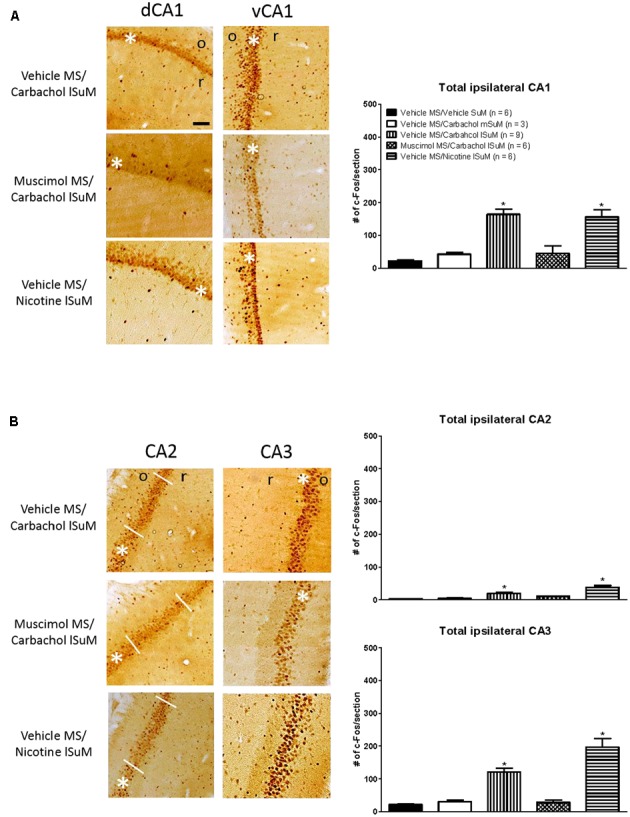
Medial septum modulates the carbachol-induced expression of c-Fos in the ipsilateral hippocampus. (A) On left are digital images showing c-Fos-like immunoreactivity (c-Fos-ir) in coronal sections taken through the dorsal hippocampus field CA1 (dCA1; posterior ∼3.00 mm from Bregma) and the ventral hippocampus field CA1 (vCA1; posterior ∼4.80 mm from Bregma). c-Fos-ir neurons are observed as a dark spherical structures against a lighter brown background. White asterisk on the figures indicates the pyramidal cell layer while “o” and “r” on the figures denote stratum oriens and stratum radiatum, respectively. The sections are taken from animals’ microinjected with combination of vehicle and a cholinergic agonist (carbachol or nicotine) into MS and SuM, respectively. The combination is denoted by “treatment region/treatment region” shown on left of the digital images. Thus, for example, an experiment involving microinjection of vehicle into MS and the cholinergic agonist, carbachol, into lSuM is indicated as “Vehicle MS/Carbachol lSuM”. On right is histogram illustrating changes in the number of c-Fos-ir neurons in CA1 on microinjection into MS and SuM. Note the robust increase in c-Fos-ir in the “Vehicle MS/Carbachol lSuM” and “Vehicle MS/Nicotine lSuM” groups. The carbachol-induced increase was prevented by microinjection of muscimol into MS (Muscimol MS/Carbachol lSuM). (B) Effect of drug microinjections on the number of c-Fos-ir neurons in hippocampal fields CA2 and CA3. The figure is built as explained for (A). Data are mean ± SEM. Significant difference (p < 0.05): ∗ vs. Vehicle MS/Vehicle SuM and Vehicle MS/Carbachol mSuM. Statistical analyses were performed using Kruskal–Wallis statistic followed by Dunn’s Multiple Comparison Test. Scale bar represents 100 μm.